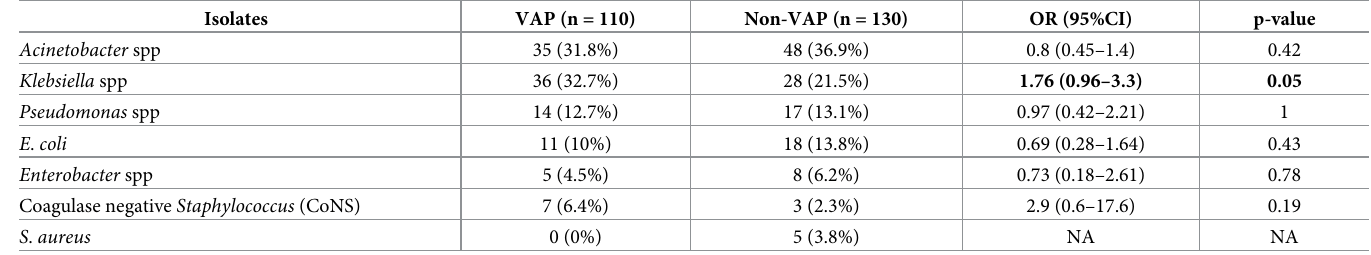
Table 4. Etiology of VAP and non-VAP